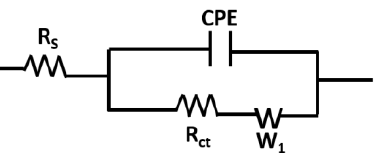
Figure 9. Modified Randles circuit representing the equivalent circuit model to fit the Nyquist curves of the EIS measurements.